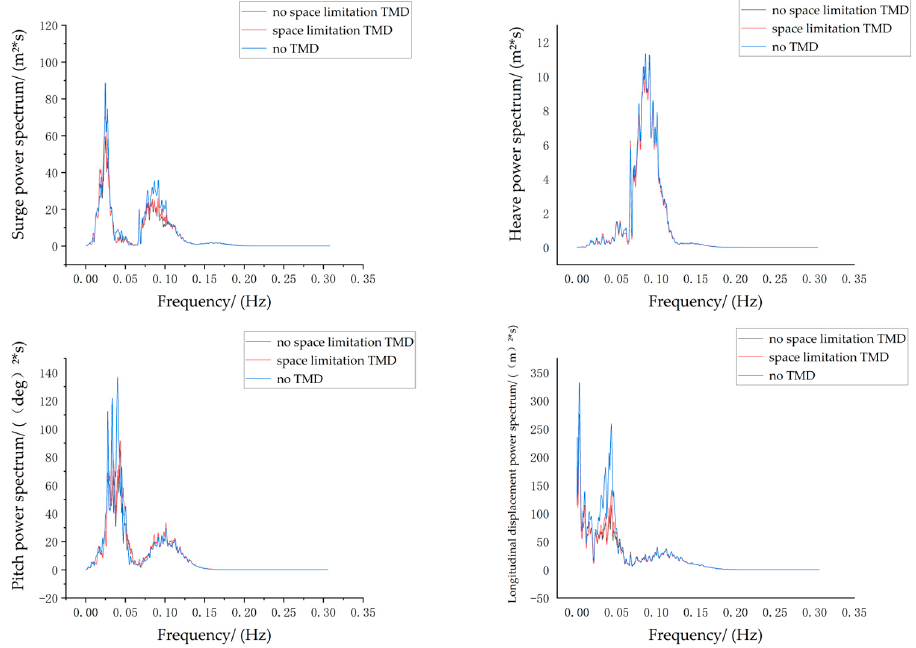
Figure 16. Comparison of floating wind turbine response in frequency domain under storm self- survival conditions.